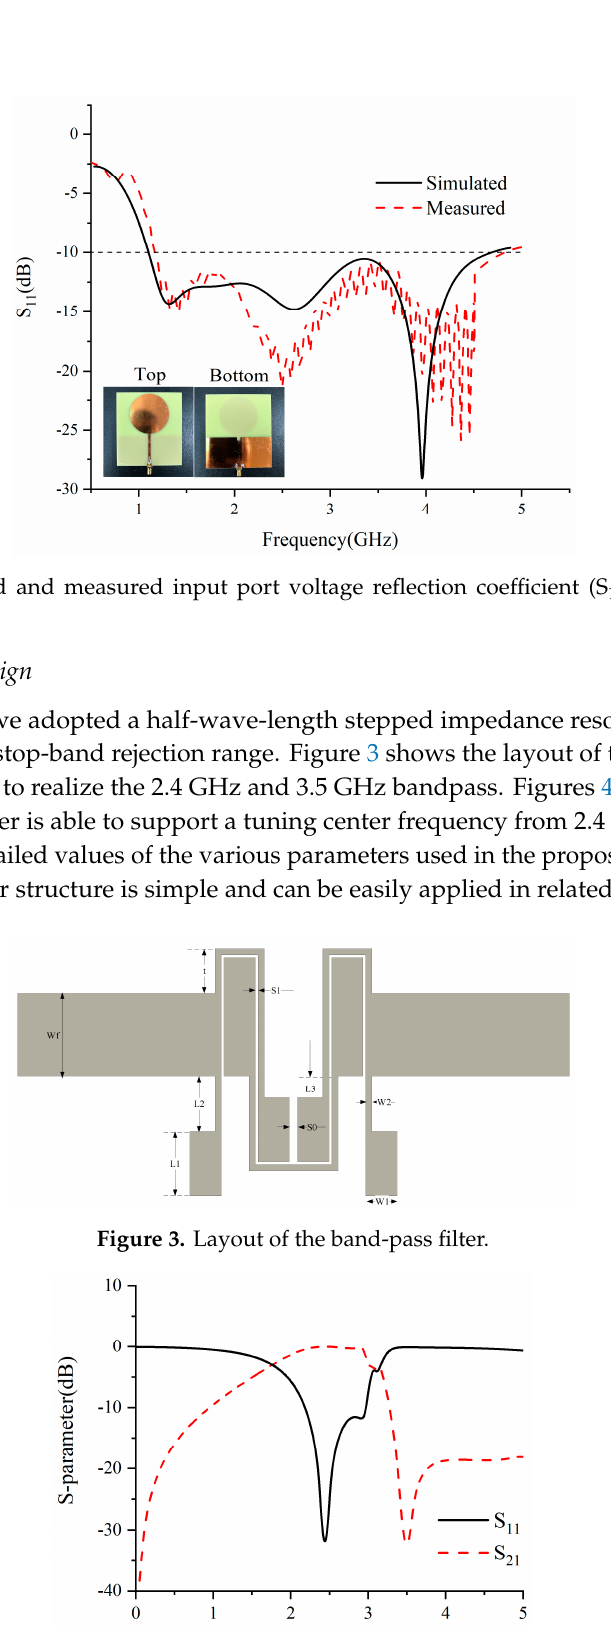
Figure 4. The simulated scattering parameters (S-parameters) of filter at 2.4 GHz.